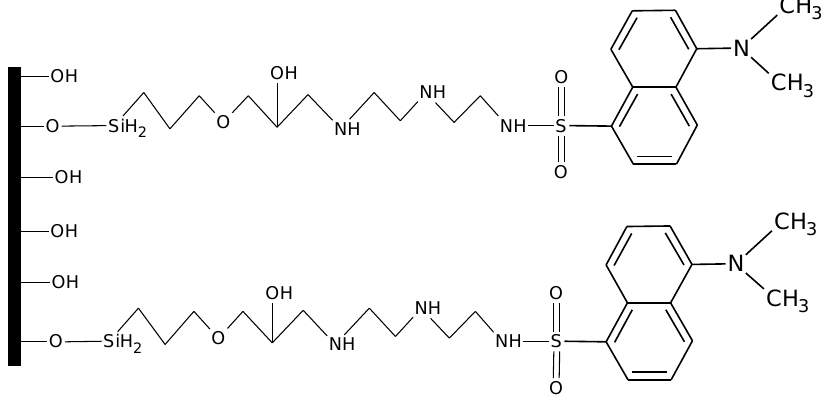
Figure 5. The chemical structure of DDETA, bound to a glass